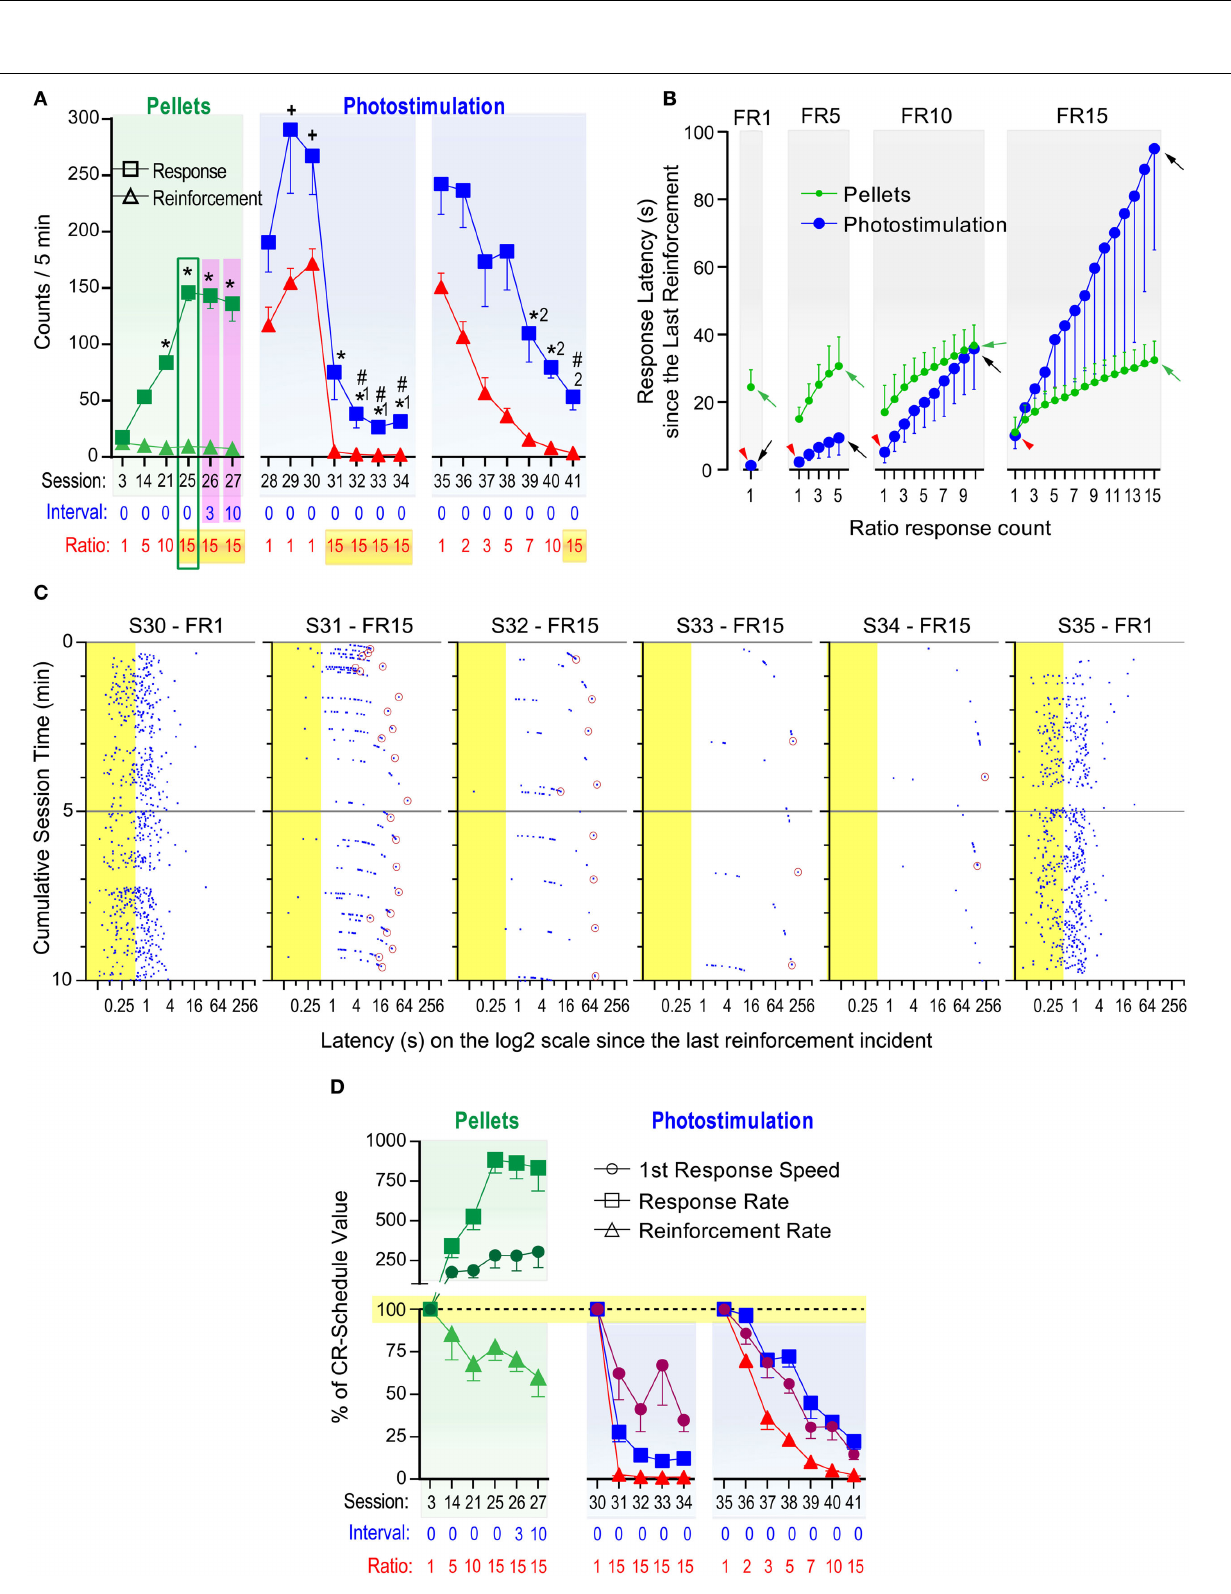
last delivery of reinforcer. (A) Mice were trained to respond for food pellets over 27 sessions. * P < 0 . 005, significantly greater than the session-3